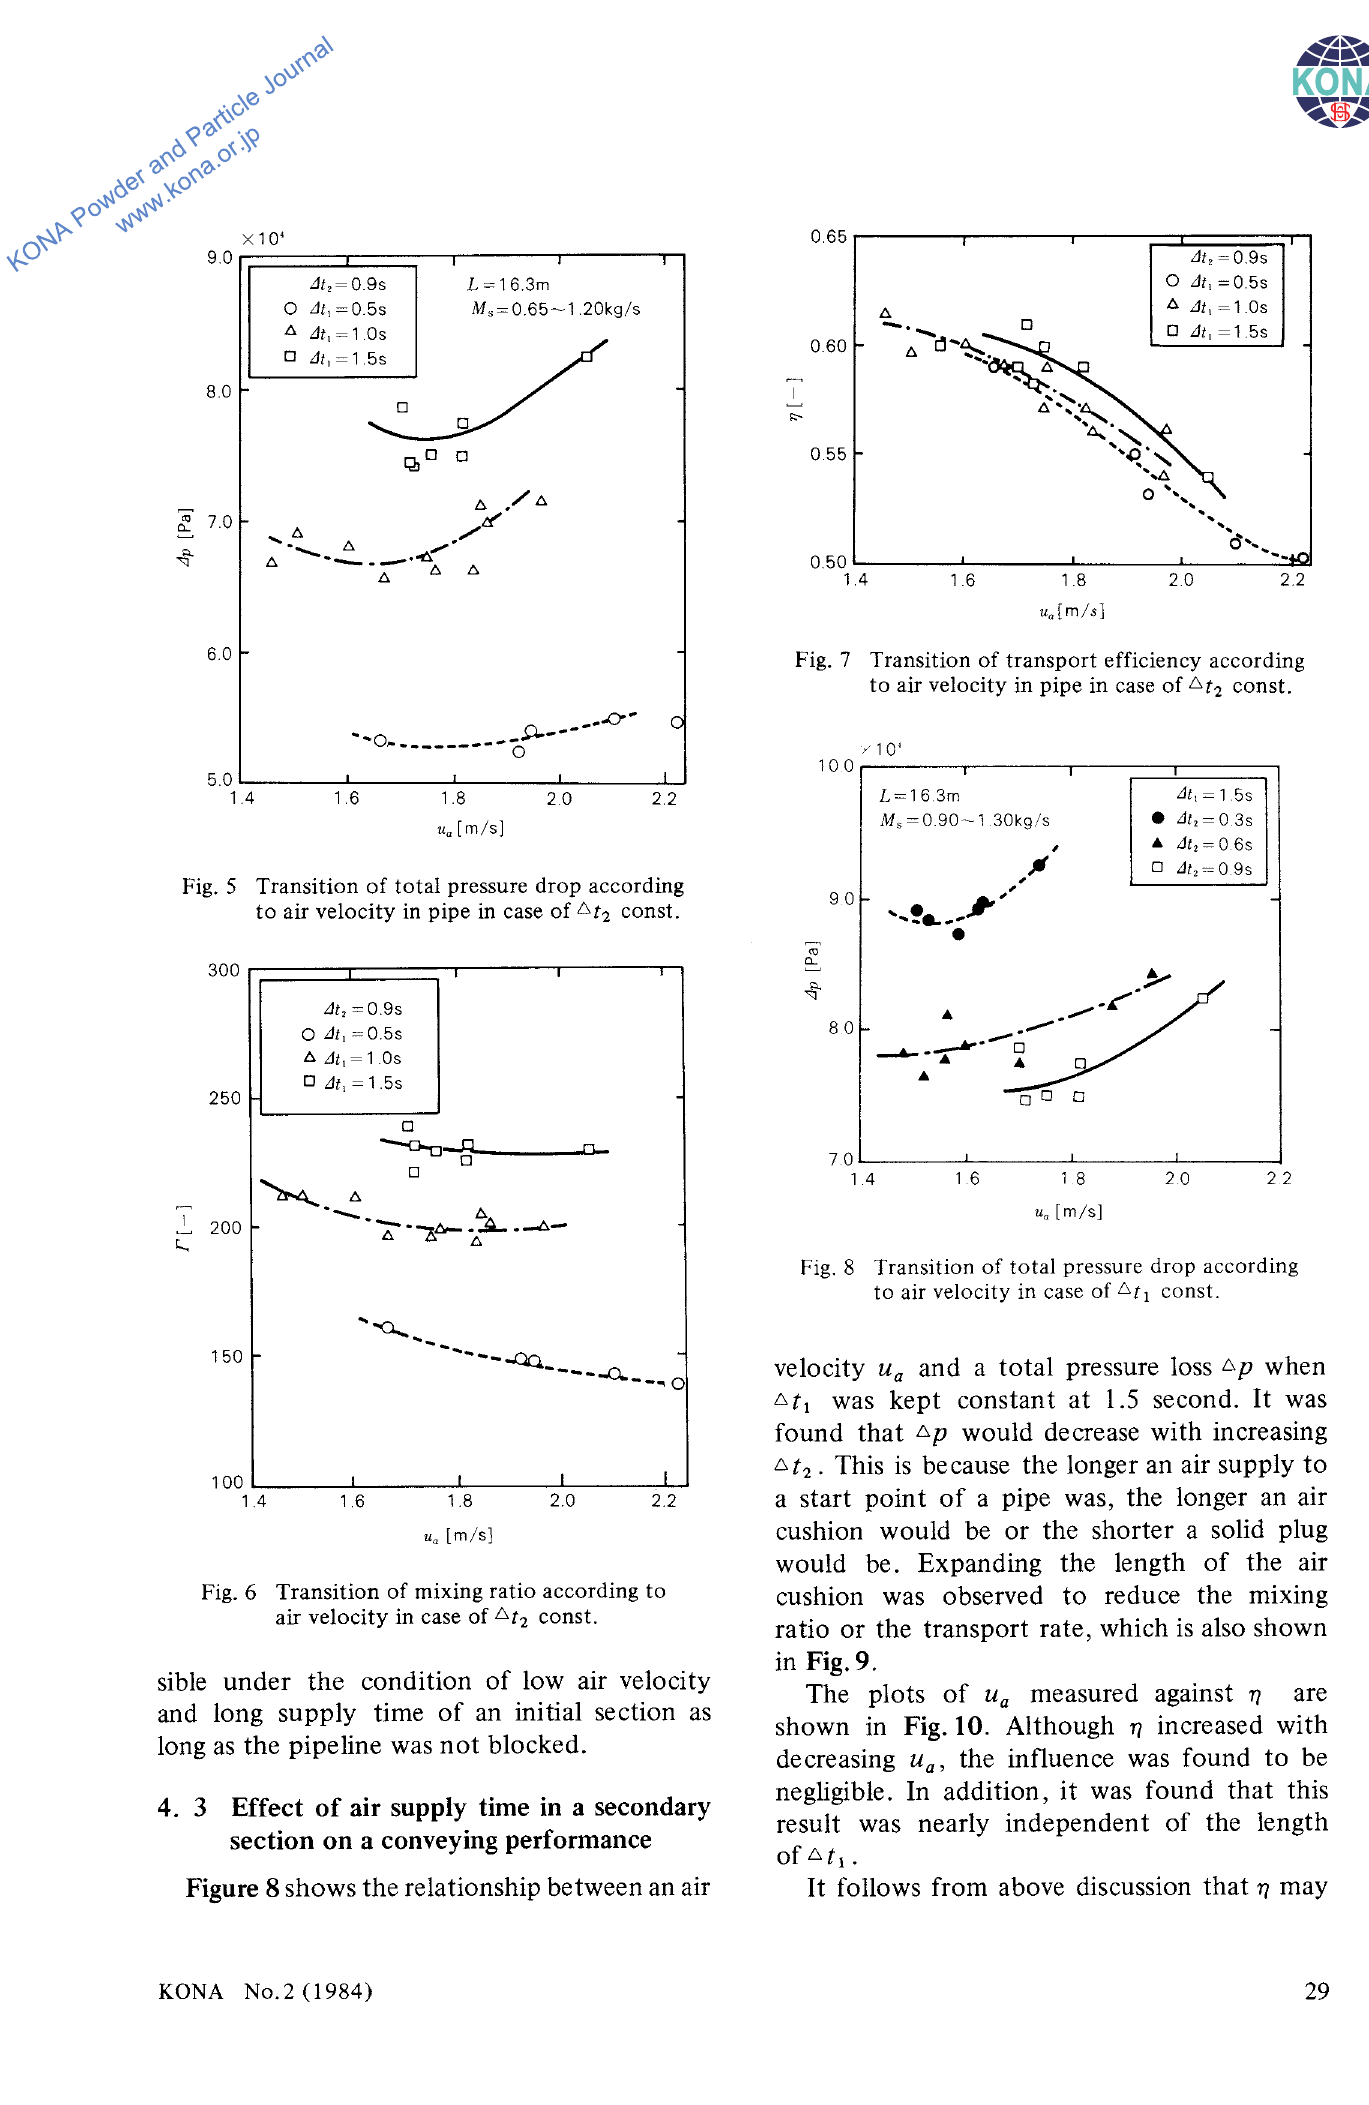
Fig. 6 Transition of mixing ratio according to air velocity in case of 6t2 const.